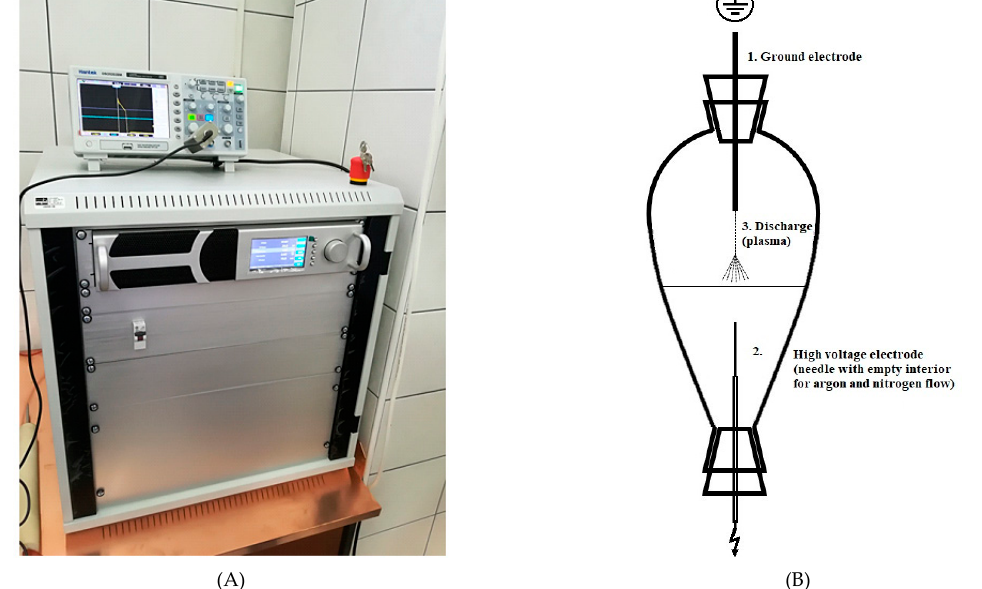
Figure 1. Set-up of generator and reactor for high voltage electrical discharges (HVED) treatments. ( A ) HVED and plasma generator “IMP-SSPG-1200” (Impel group, Zagreb, Croatia); ( B ) Beaker shaped reactor. Table 1. Denotation of sample for high voltage electrical discharges (HVED) treatments.